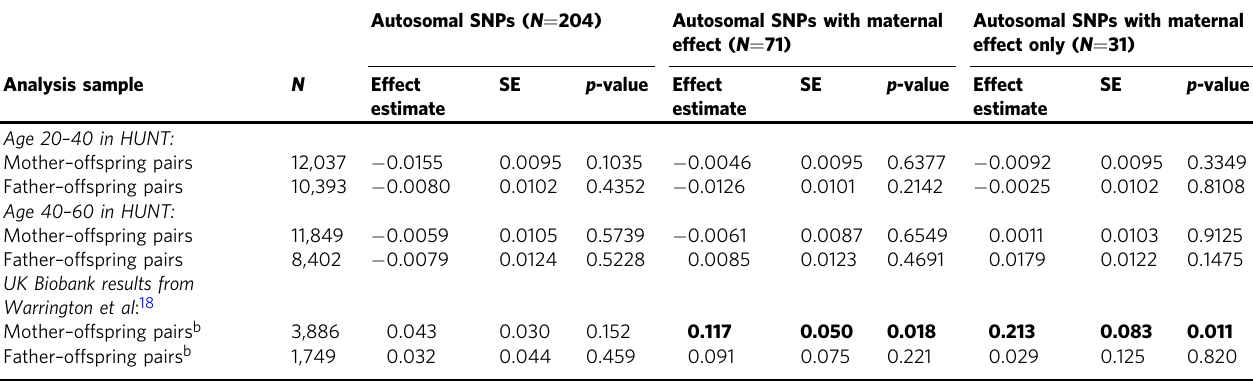
Allanalysisareadjustedforage,sex,measurementoccasionandGRSofoffspring.Resultswith p -valueslessthan0.05areshowninbold.EffectestimatesandstandarderrorsinHUNTarestandardized. The regression coef fi cients give the estimated expected change in offspring SBP (mmHg) per one unit (i.e. allele) increase in maternal/paternal genetic risk score after conditioning on offspring genetic risk score. P -values re fl ect minus two log-likelihood chi-square tests between the full model and a sub-model where the relevant parameter is fi xed to zero. All p -values are two sided uncorrected